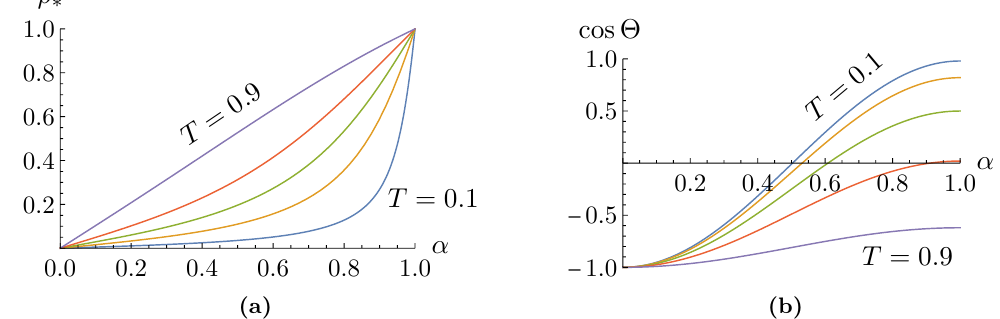
Figure 15. The intersection depth in terms of (a) the Poincaré disk radial coordinate (3.23) and (b) the intersection angle of two annulus branes with tensions T ≡ T 1 = − T 2 as a function of the conical defect parameter α